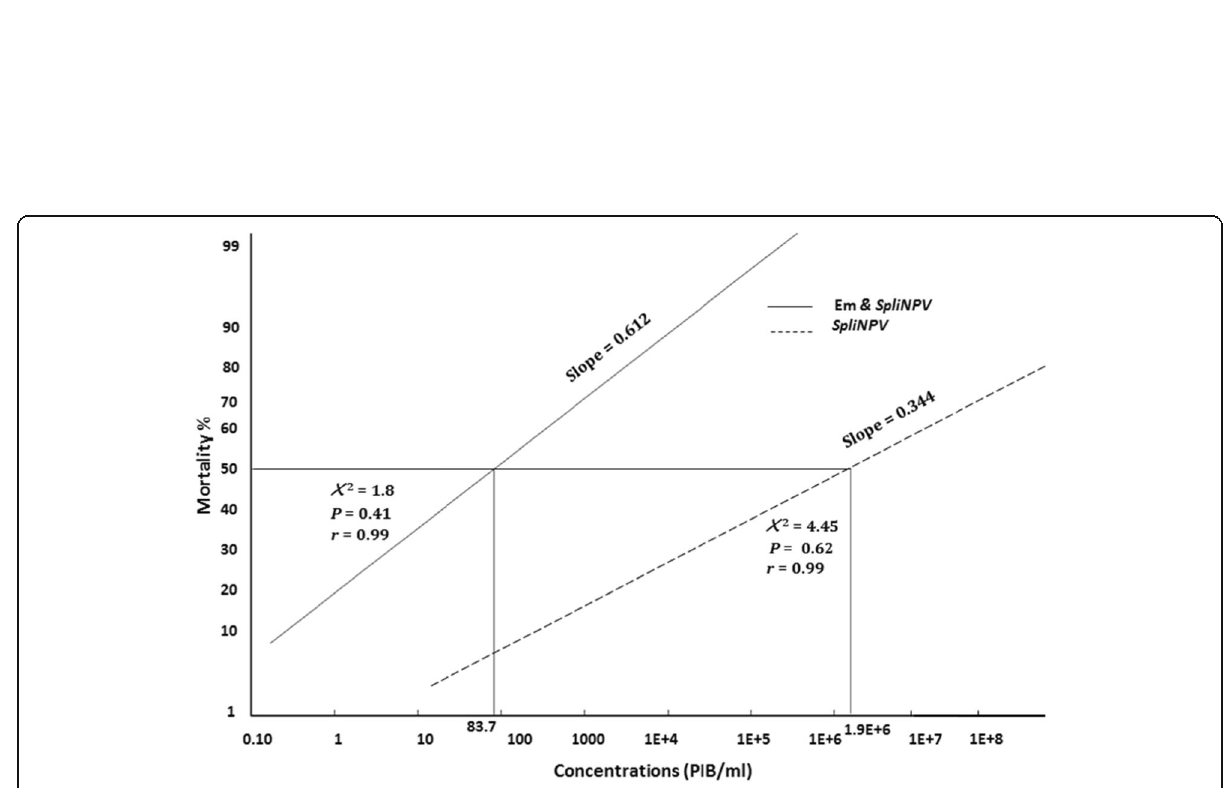
Fig. 2 % mortality of Spodoptera littoralis treated as 2nd instar larvae with different concentrations of Spli MNPV (PIB/ml) and ( Spli MNPV concentrations PIB/ml) + Em 0.05